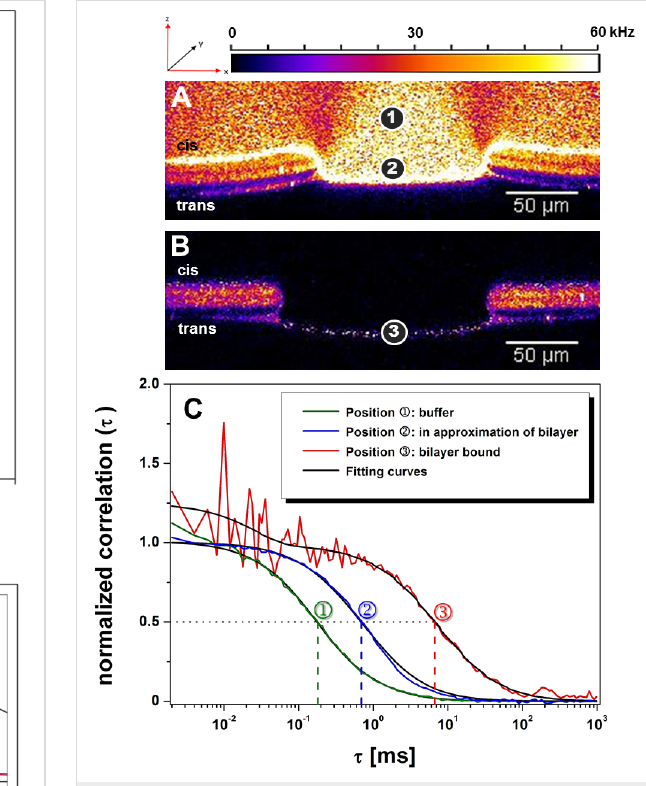
Figure 13: Diffusion time measurements of LON 10 (5 µL, 50 nM). A) Z-direction scan directly after the addition of the oligomer probe into the cis compartment of the bilayer chip. B) Z-direction scan after 7 perfusion/incubation cycles upon which unbound oligomer was completely washed out. This allows a diffusion time measurement of bilayer-bound LON 10 . C) Normalized and fitted correlation curves of the measured diffusion times at positions 1, 2 and